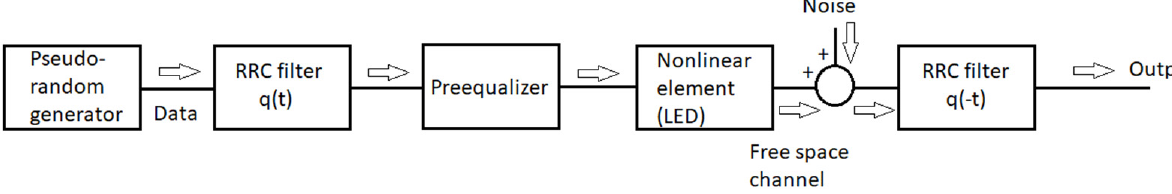
Figure 3. Post-equalizer configuration.